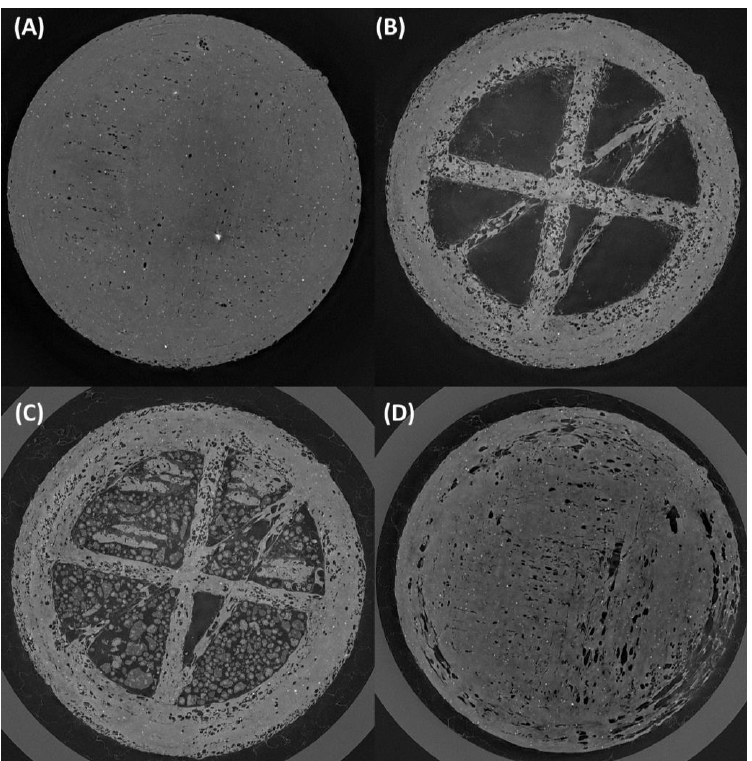
Figure 10. Micro-CT images of CUR- and LNS-loaded SNEDDS-filled prints: ( A ) first printed layer, ( B ) cross support printed after the first layer to prevent collapsing of the hollow print during the additive manufacturing process, ( C ) SNEDD-loaded prints at 80% with hollow space occupied by the drug-loaded SNEDDS, and ( D ) top layer post the sealing process.